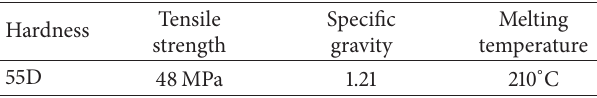
Table 4: The combination parameters for the effective